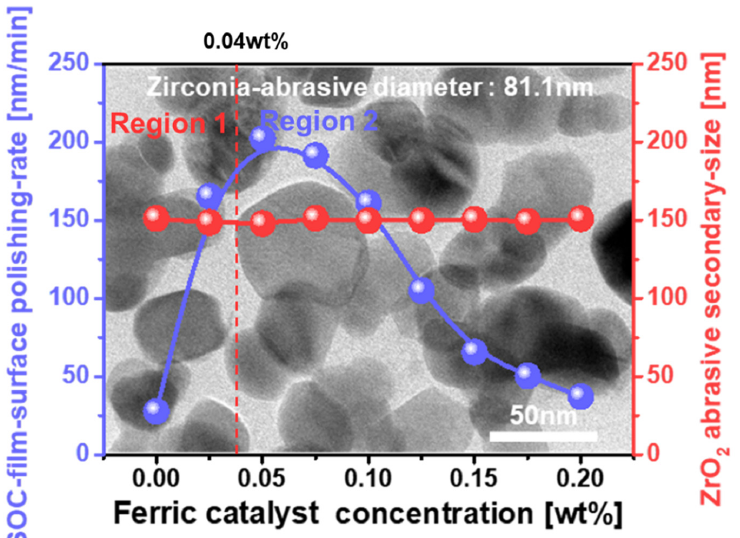
Figure 2. Effect of the ferric catalyst (Fe 2 (SO 4 ) 3 H 2 O)) on the SOC film polishing rate and the ZrO